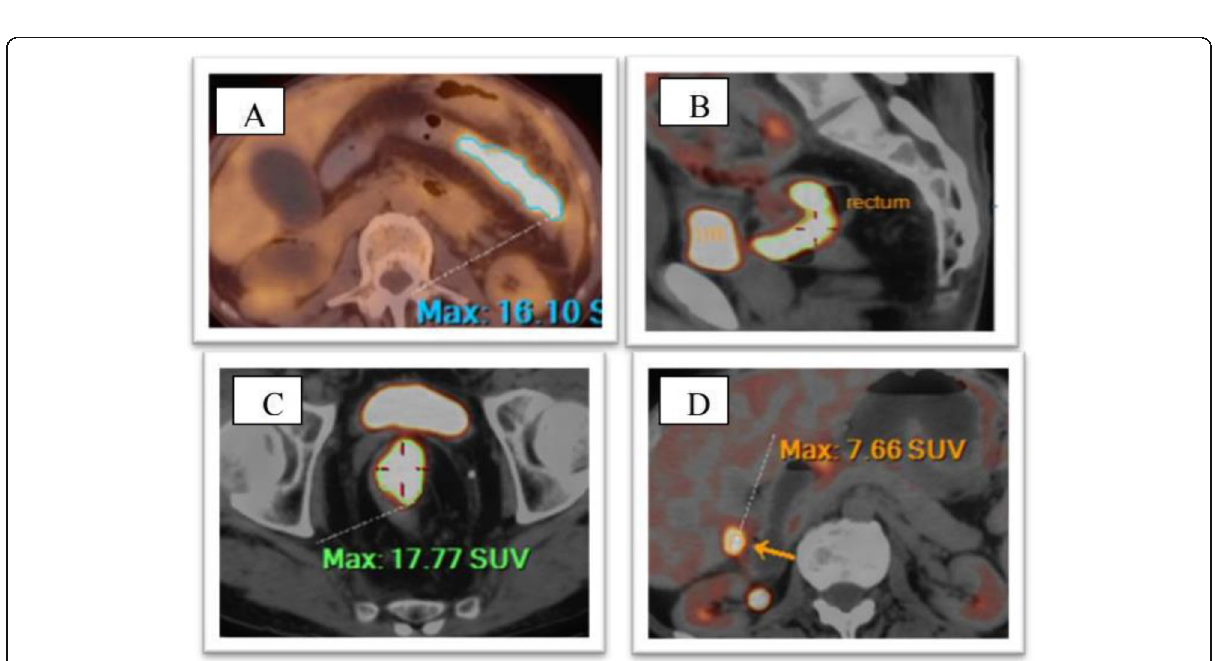
Fig. 3 A 61-year-old male patient with a history of colon cancer treated by surgical resection. He was referred for PET/CT assessment due to elevated CEA. a , c , d Axial PET/CT cuts through the abdomen and the pelvis, b sagittal PET/CT through the pelvis showing the following: irregular thickening of the wall of distal transverse colon with hypermetabolic activity reaching up to 16 SUV max proved to be malignant on endoscopy and biopsy ( a ); irregular mucosal mass at the rectum projecting into its lumen with hypermetabolic activity reaching up to 17.7 SUV max ( b , c ); and the liver showing a small hypermetabolic focal lesion measuring 1 cm and achieving 7.6 SUV max ( d